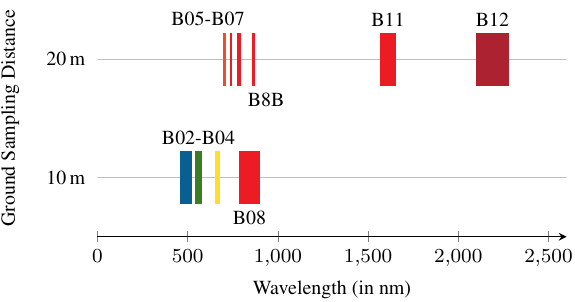
Figure 2. Spectral and spatial resolution of the Sentinel-2 bands with a GSD of 10 m and 20 m which we used in our